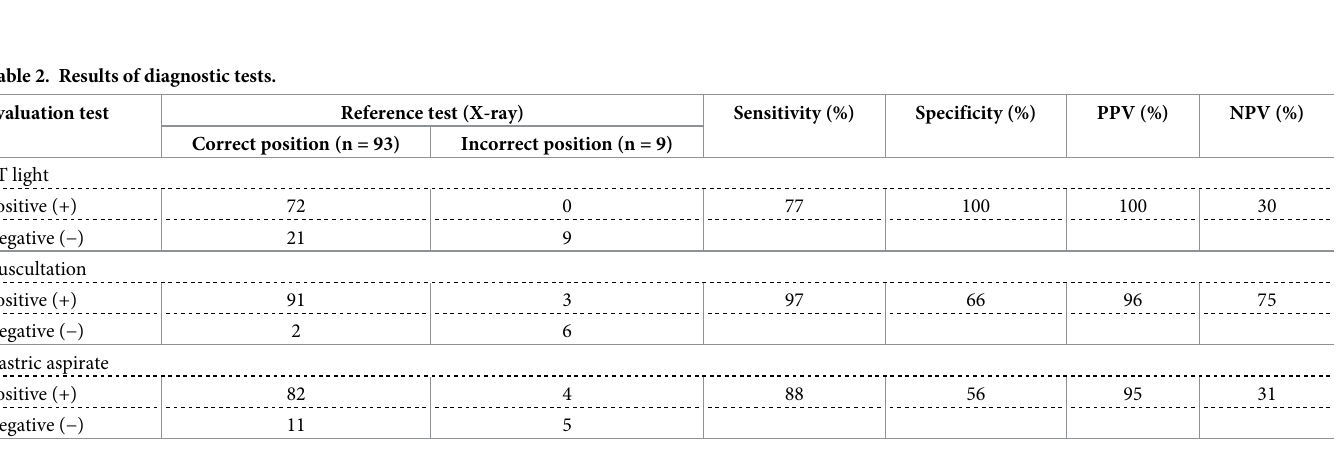
Table 2. Results of diagnostic